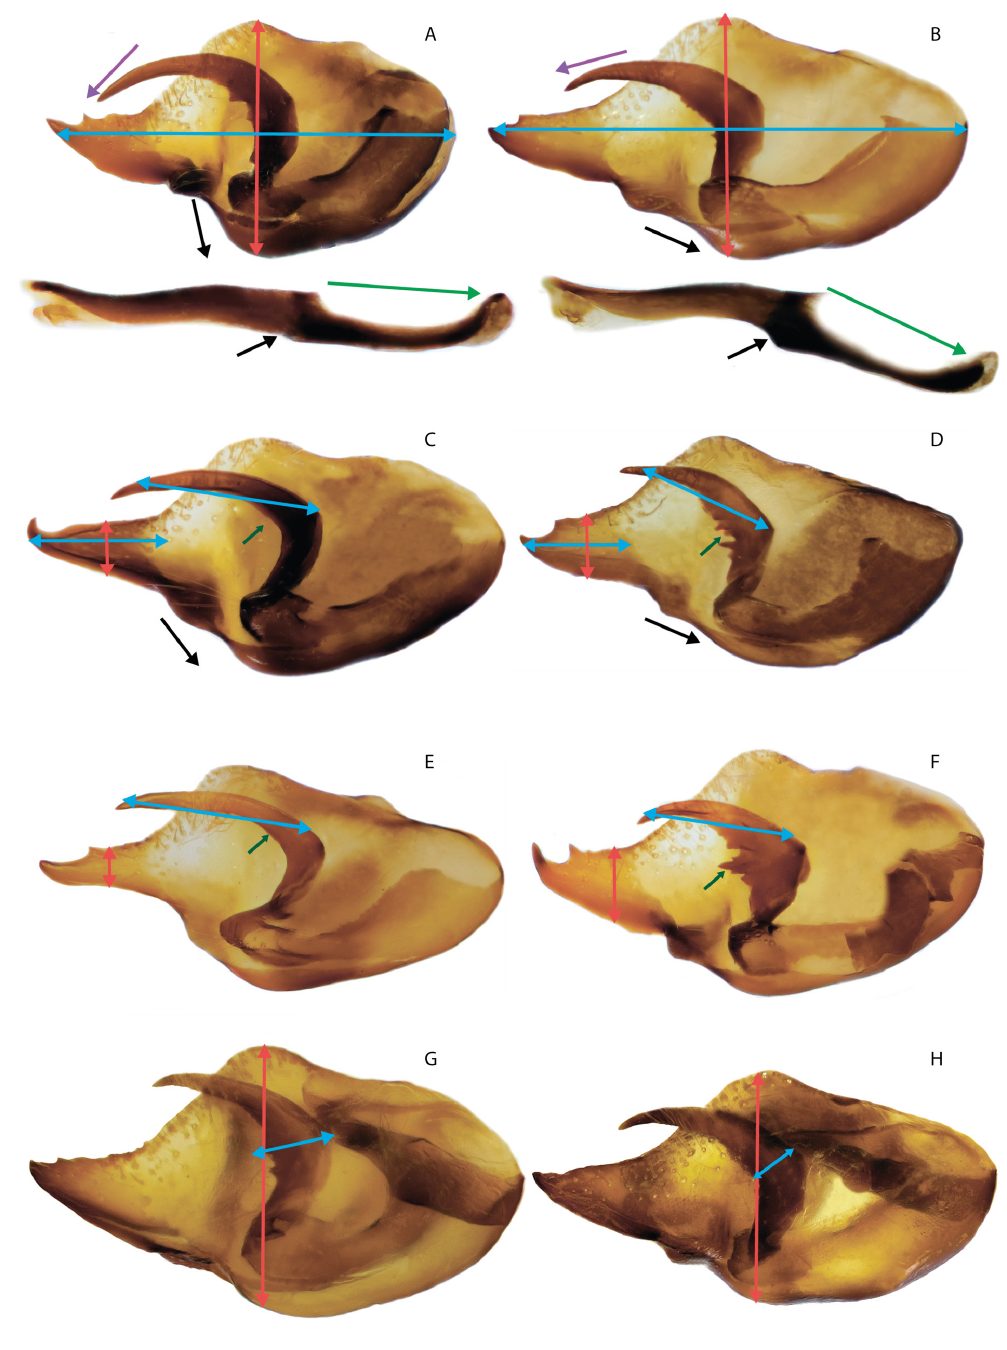
Fig. 29. Differences in the structure of valva and aedeagus of the lutko species group. A . Melitaea